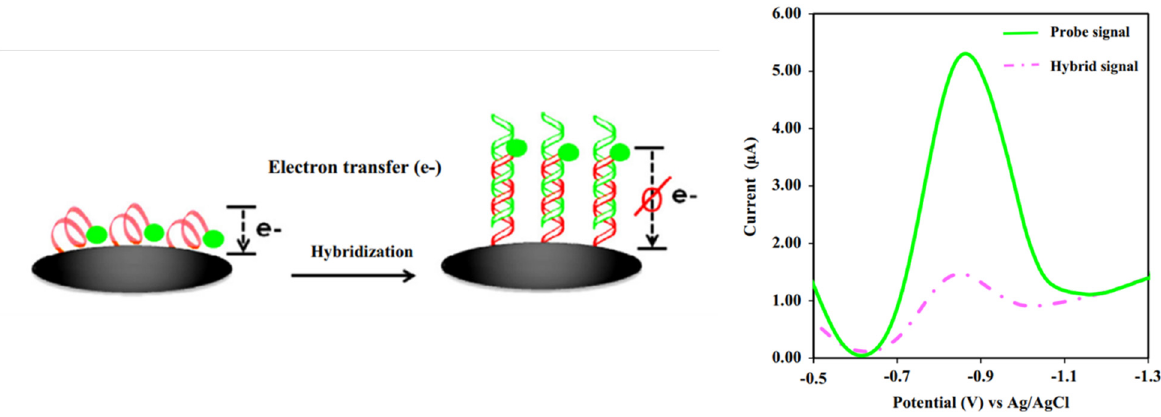
Figure 14. Schematic representation of detecting dsDNA based on a labeled system electrochemical DNA biosensor. This figure has been reproduced from Jampasa and co-workers [65].